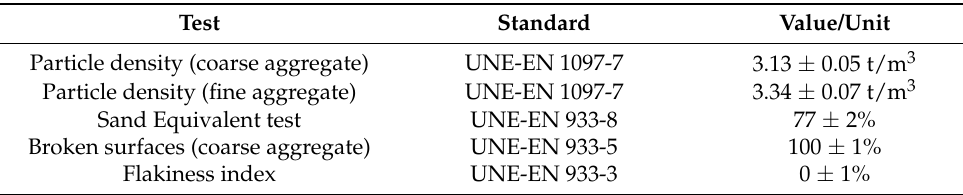
Table 9. Density and plasticity tests for the fine portion of ladle furnace